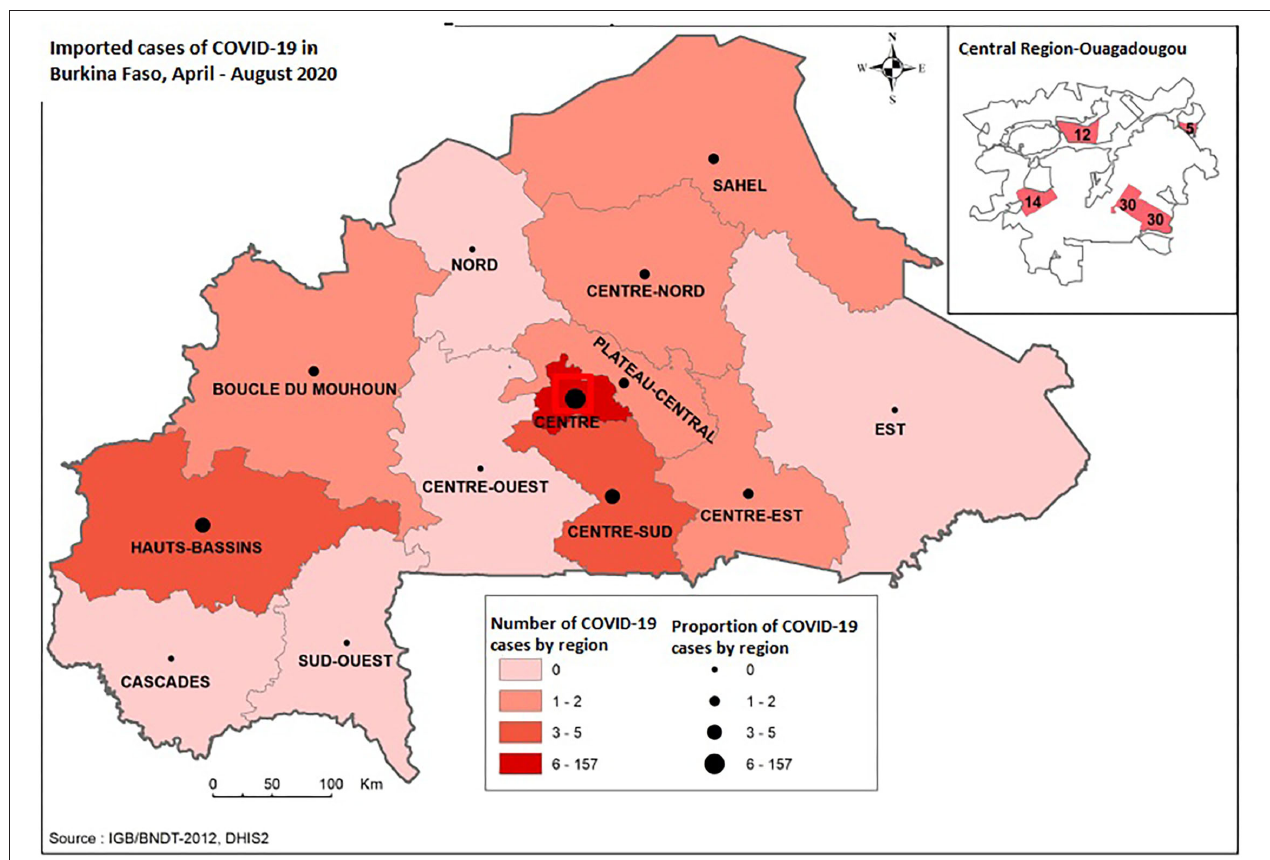
FIGURE 1 | Mapping of regions of residence of imported COVID-19 cases, April-August 2020, Burkina Faso. were retained in the final model if significantly associated ( p < 0.05) with the RT-PCR-positive test. All analyses were performed using SAS 9.4 (Cary, NC,